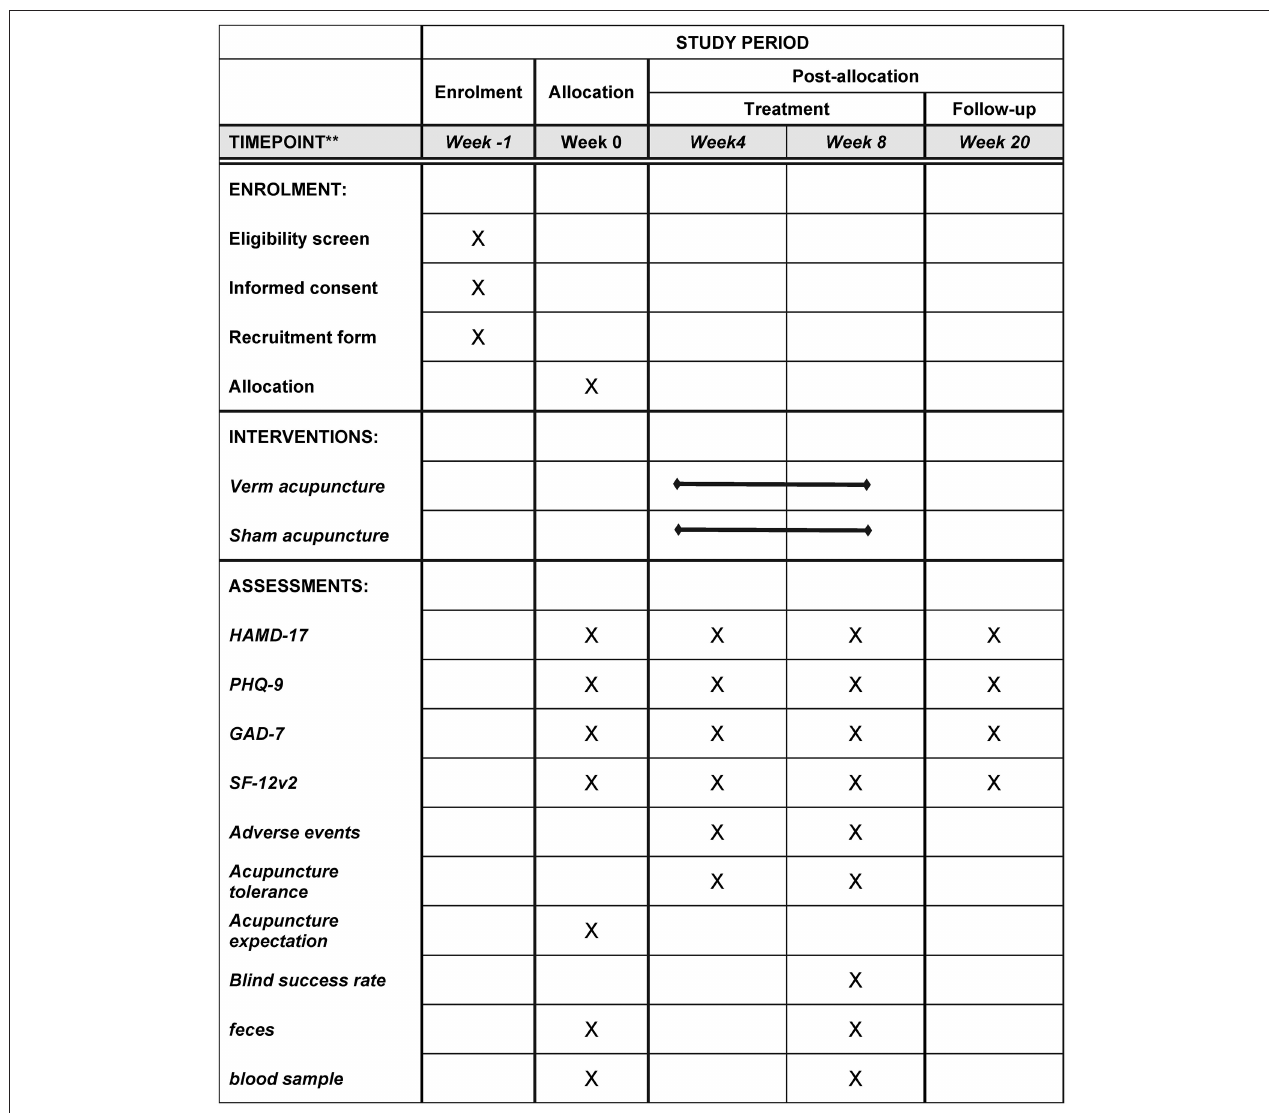
FIGURE 2 | SPIRIT figure.